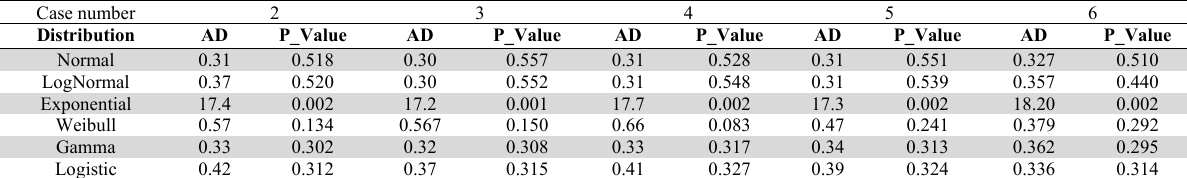
Outcomes of fitting test for the true cost of the projects.